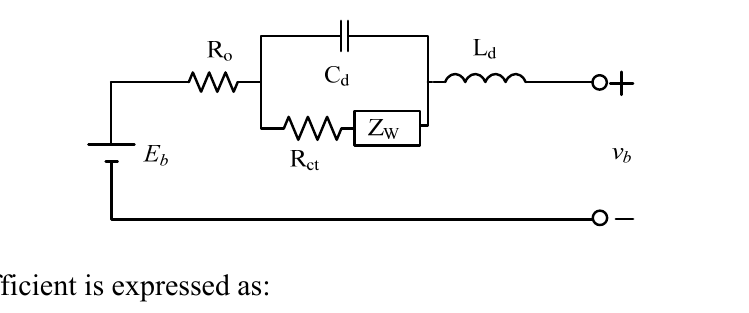
Figure 2. The Li-ion battery AC impedance